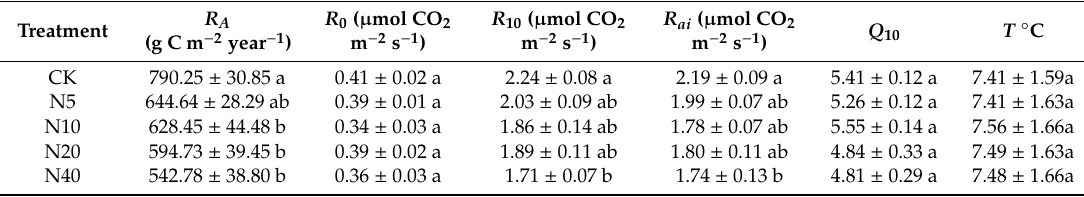
Table 3. Soil respiration variables among five nitrogen addition